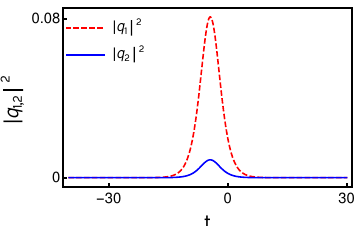
Figure 6. Degenerate one-soliton of the Manakov equation: the values of the parameters are k 1 = ( 1 ) = 1.5 + 1.5 i , α ( 2 ) = 0.5 + 0.5 i 0.3 + 0.5 i , α 1 1